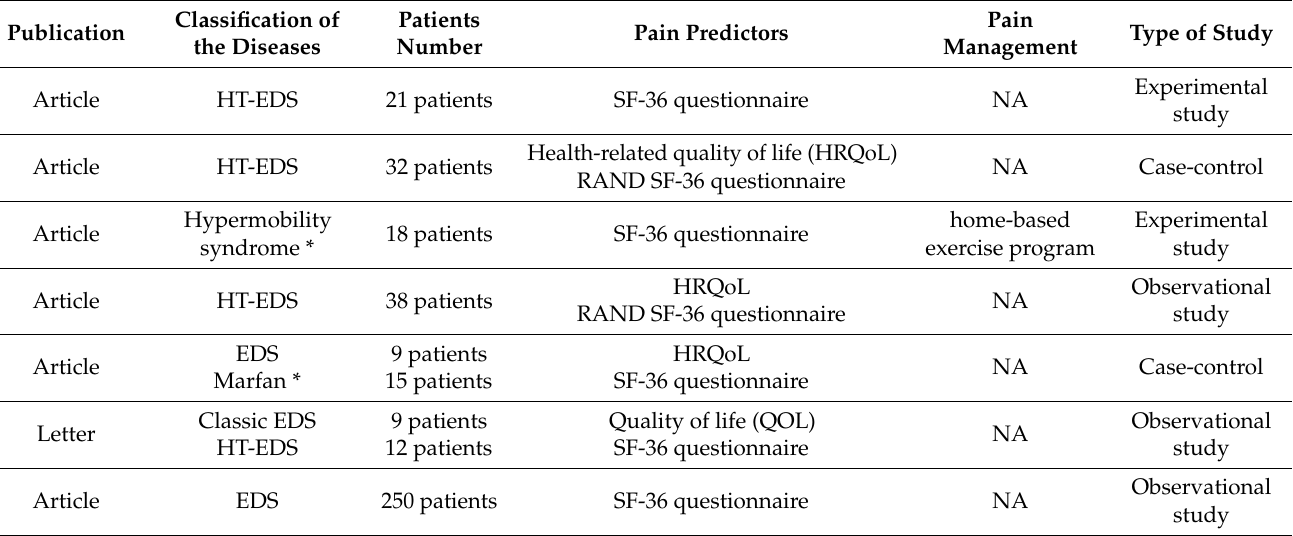
Table 2. Studies referring to pain predators and pain